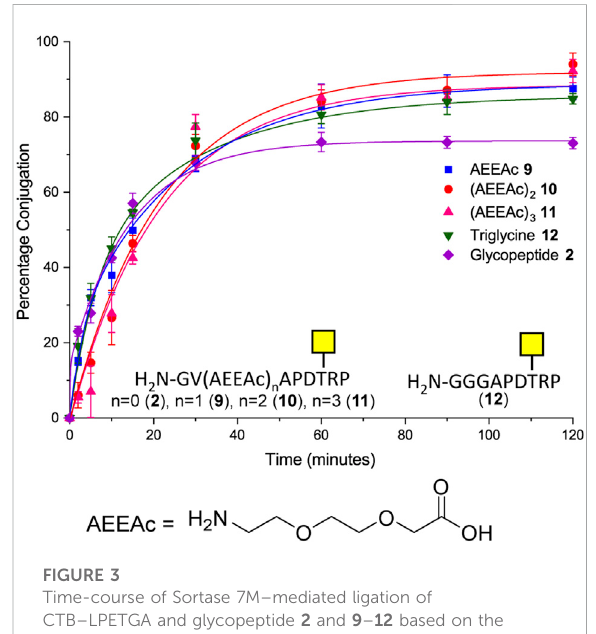
FIGURE 3 Time-course of Sortase 7M – mediated ligation of CTB – LPETGA and glycopeptide 2 and 9 – 12 based on the SM3 recognition sequence. The reaction performed in the presence of 10% DMSO. AEEAc, 8-amino-3,6-dioxaoctanoic acid. Percentage conjugation an average of three densitometry measurements and error bars indicate 2 × standard